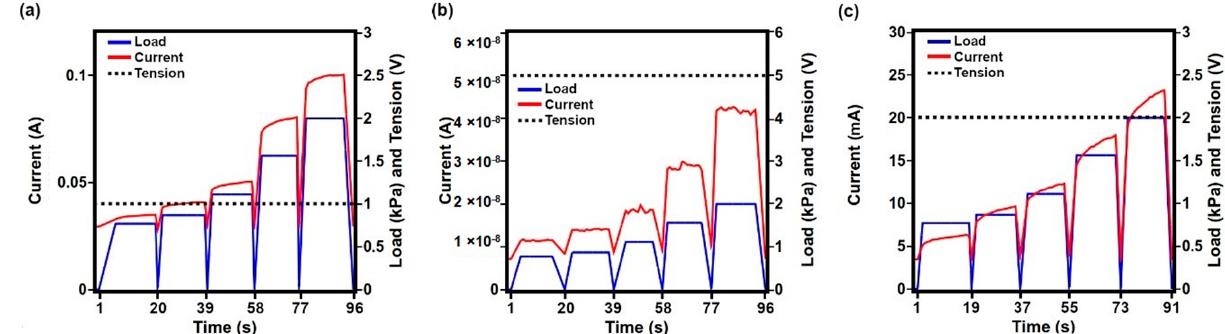
Figure 4. Graphs of static electromechanical tests: current × pressure × voltage plots for different graphene papers; ( a ) EG1, ( b ) GO1 and ( c ) rGO1.